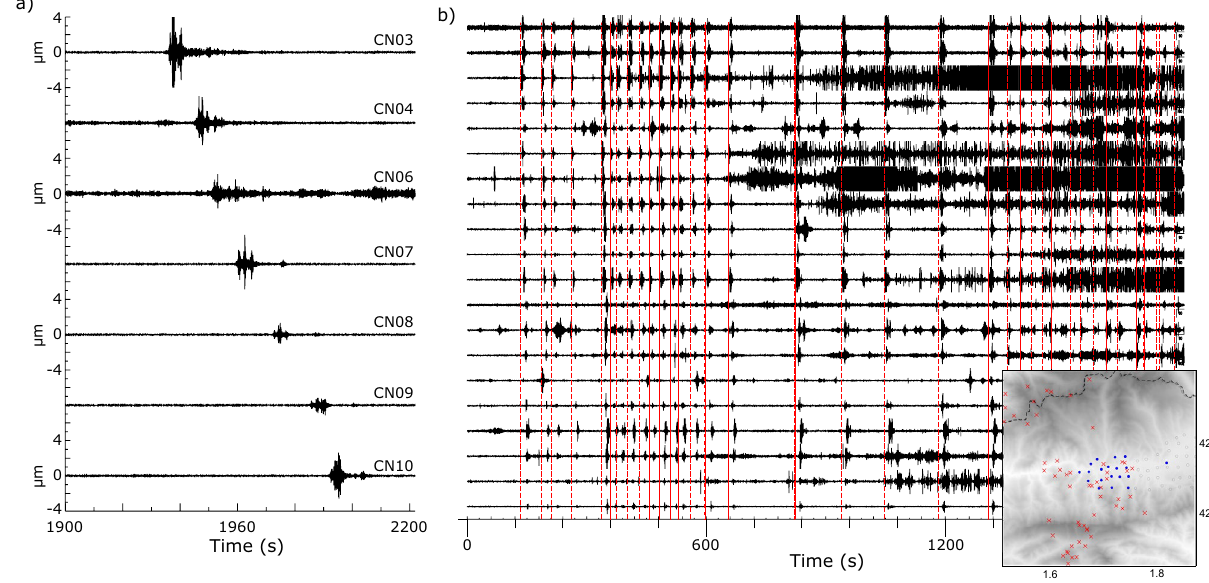
Figure 7. ( a ) Detection of signals related to a thunder sourced the 22 October 2019 using the broad-band seismic network. All the traces are shown at the same scale, with amplitudes expressed in μm/s. ( b ) 30 min of seismic data (15/6/2021 11:30–12:00 UTC, as recorded in the 20 eastern stations (blue dots in the inset map). Red dashed lines show the origin time of the lightning observations during the same time intervals, as reported by the SMC. Only the events located within less than 15 km of station C008 are included (plotted as red crosses in the inset map). Amplitudes are represented at a common scale and expressed in digital counts. Traces are ordered following longitude, with westward sites on